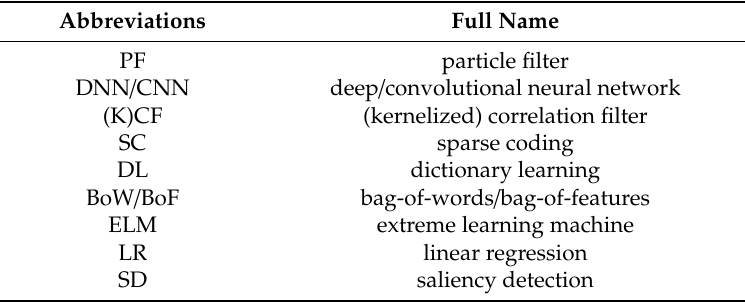
Table 2. Abbreviations for name of the